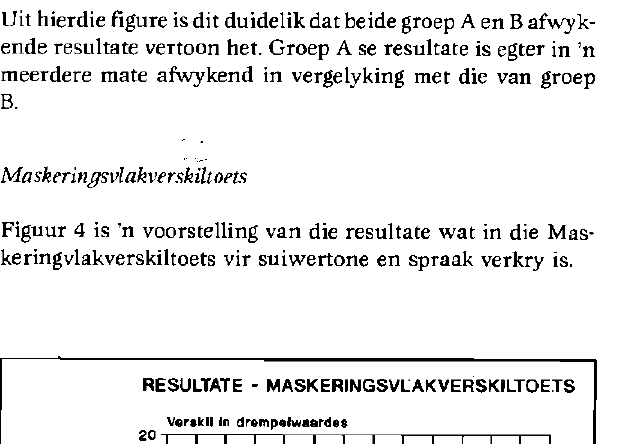
-Met o.m. Figuur 3(b): Resultate van SSI-IKB (regs)